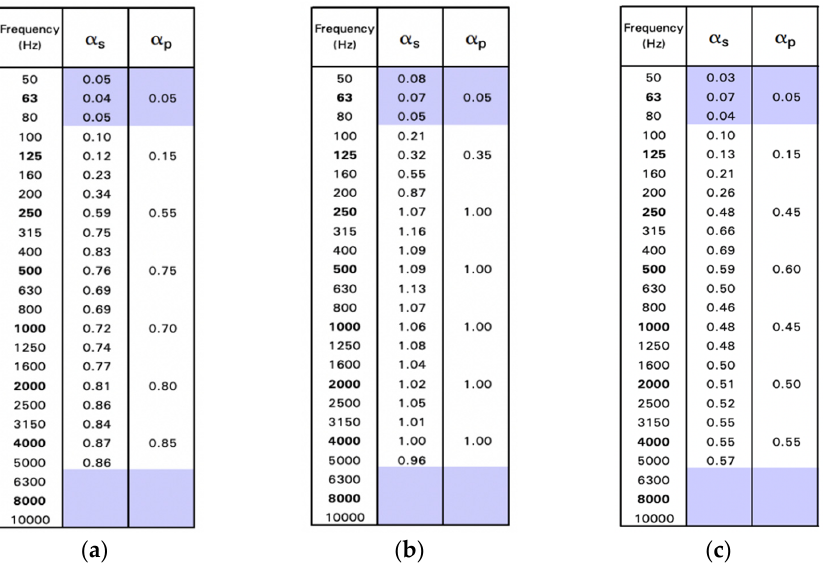
Figure 5. Measurements of sound absorption coefficient according to BS EN ISO 354:2003: ( a ) Biotecture green wall system with fully planted panels; ( b ) Biotecture living wall system with dry panels; ( c ) Biotecture green wall system with wet un-planted panels. Weighted sound absorption coefficient ( α w ) according to [45] a single-valued fre- quency-independent value equal to the value of the reference curve at 500 Hz after it has been shifted.